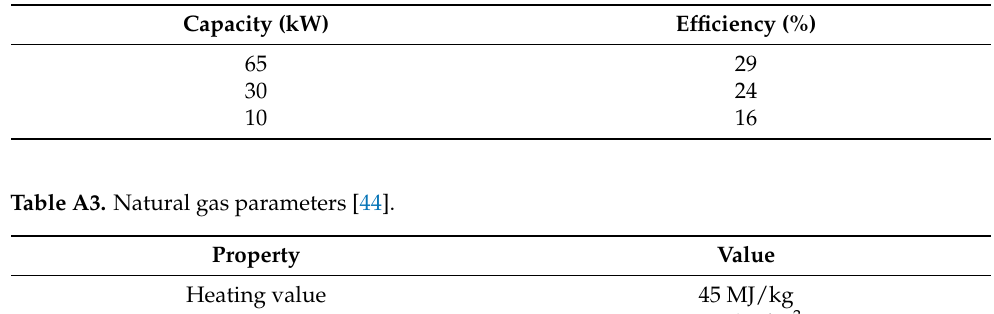
Table A2. Microturbine electric efficiency LHV [44].